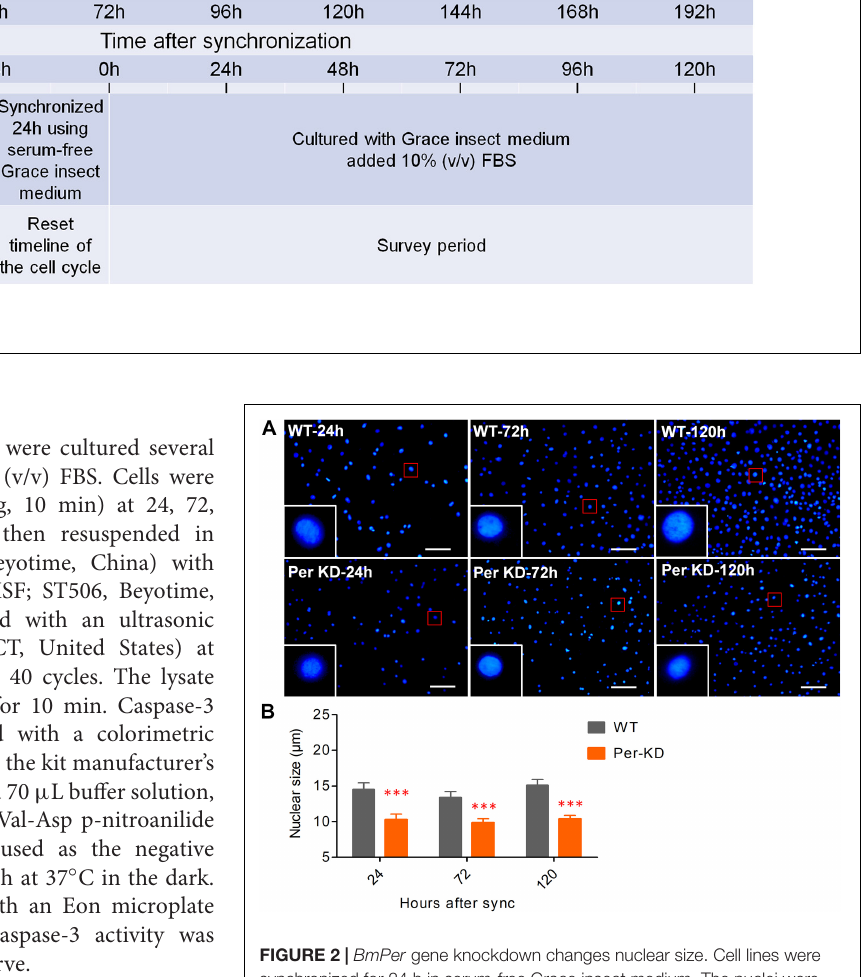
FIGURE 2 | BmPer gene knockdown changes nuclear size. Cell lines were synchronized for 24 h in serum-free Grace insect medium. The nuclei were stained after 24, 72, and 120 h of culture in medium with 10% (v/v) FBS. (A) Cell nuclei were stained with 4’-6-diamidino-2-phenylindole (DAPI). Bar = 100 µ m. (B) Nuclear size. ∗∗∗ p < 0.001 ( n = 3 plates with size measurement of 120 nuclei). WT, wild-type BmN cells; Per-KD, BmPer knockdown BmN